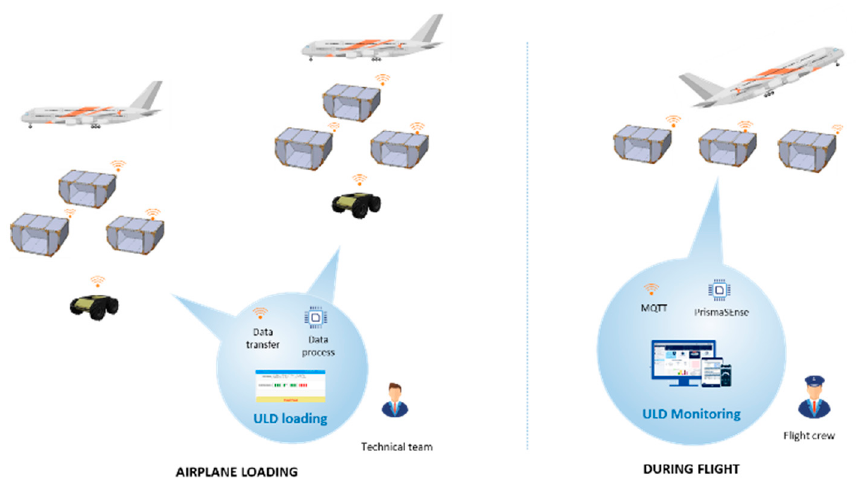
Figure 2. General